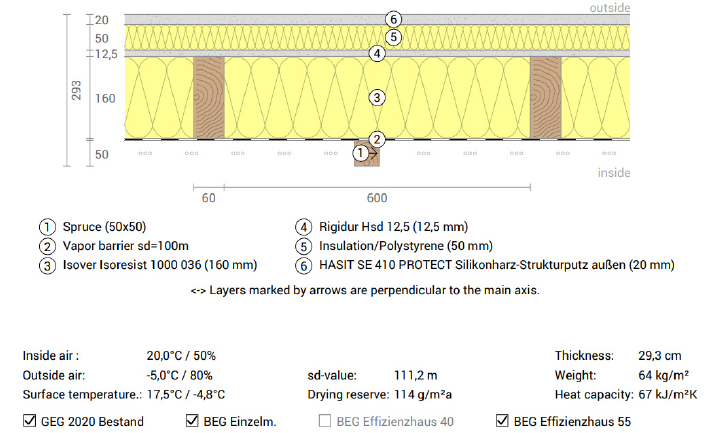
Figure 24. A section showing the wall layers in a frame building.